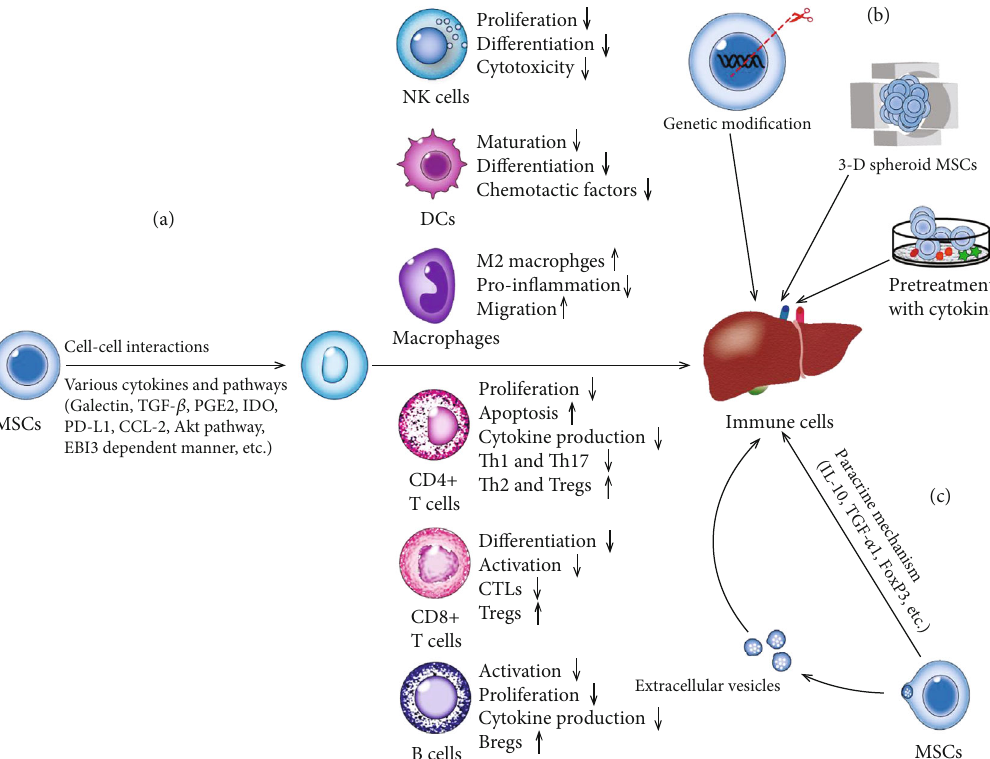
Figure 2: The mechanism of immune tolerance induced by mesenchymal stem cells (MSCs). (a) MSCs regulate the maturation, proliferation, di ff erentiation, and apoptosis of immune cells to generate a tolerogenic microenvironment via cell-cell interactions and diverse cytokines and signal pathways. (b) Preconditionings to induce immune tolerance. The capacity of immune regulation of MSCs might be in fl uenced by the pretreatment with cytokines, genetic modi fi cation, and culture method (three-dimensional (3D) culture or 2D culture). (c) Paracrine mechanisms and extracellular vesicles derived from MSCs to induce immune tolerance after liver transplantation. TGF- β : transforming growth factor-beta; PGE2: prostaglandin E2; IDO: indoleamine 2,3-dioxygenase; PD-L1: programmed cell death-ligand 1; CCL-2: chemokine ligand-2; EBI3: Epstein-Barr virus-induced 3; IL-10: interlukin-10; FoxP3: forkhead box P3; NK: natural killer; DCs: dendritic cells; CTLs: cytotoxic T lymphocytes; Tregs: regulatory T cells; Bregs: regulatory B cells; Th1: T helper